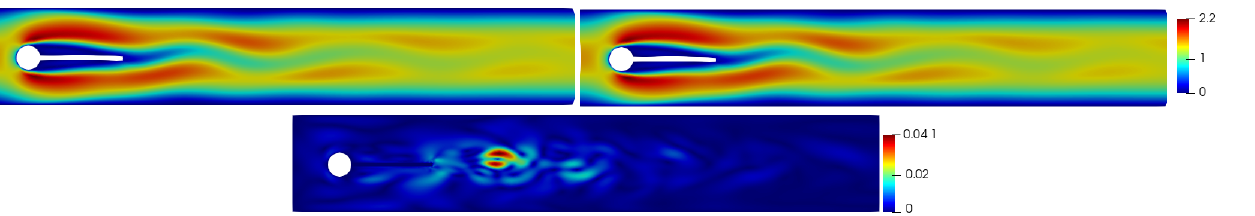
Figure 10. Fluid pressure approximation without the implementation of the supremizer enrichment: solution before the code diverges.